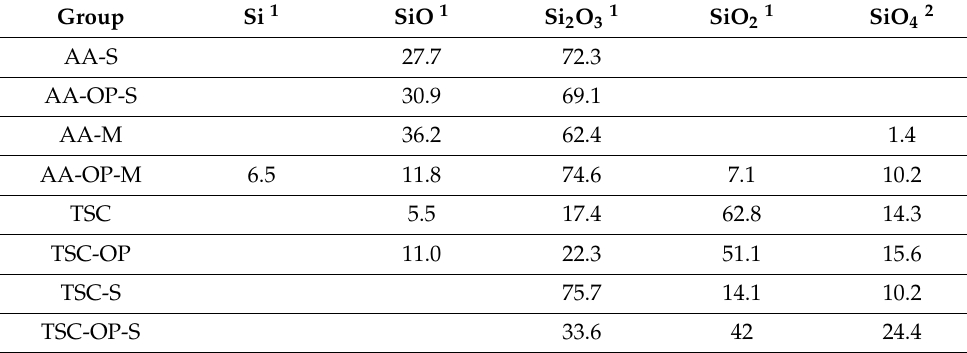
Table 2. Area percentages (%) of different chemical states in the deconvoluted Si 2p peaks.